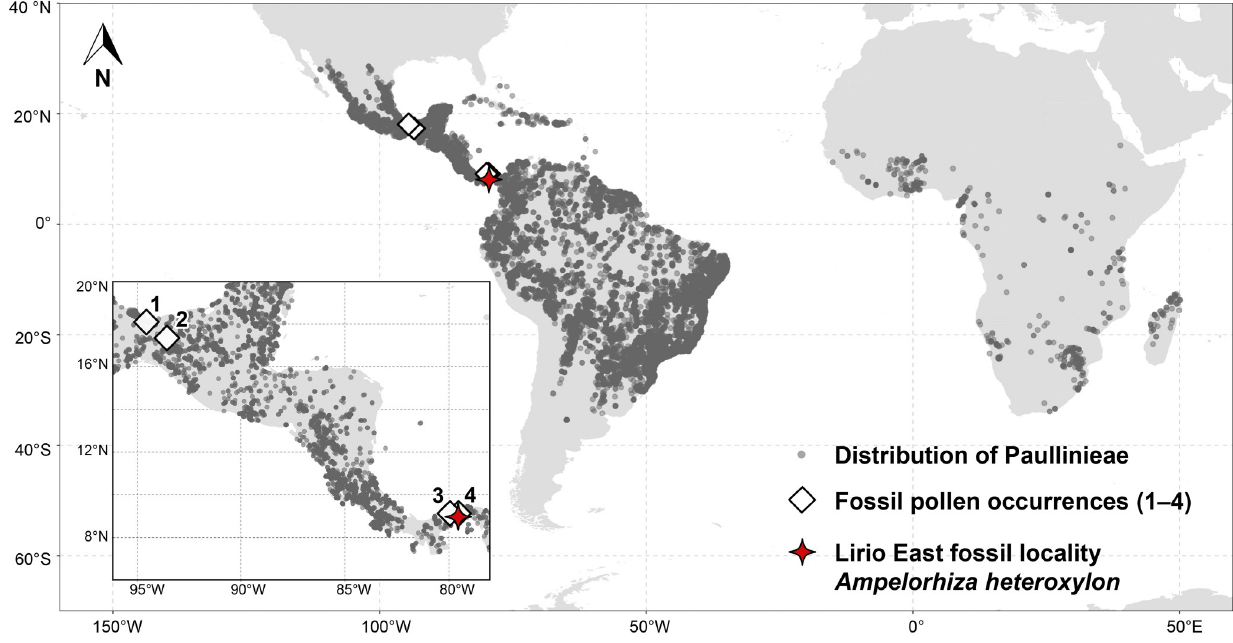
Fig 1. Native distribution of Paullinieae and fossil occurrences. Modern occurrence data from the BIEN database [45, 46]. Red star indicates the location of the Lirio East fossil site where the fossil roots were collected. Fossil pollen occurrence codes: 1 = Serjania sp., upper Miocene Paraje Solo Formation [47– 49]; 2 = Serjania sp. and Paullinia sp., lower-middle Miocene Me´ndez Formation [50]; 3 = Serjania sp. and Paullinia sp., upper Miocene Gatun Formation [49, 51]; 4 = Serjania sp., Paullinia sp., and Cardiospermum sp., upper Eocene Gatuncillo Formation [48, 52] Occurrence data were extracted from BIEN ver. 4.1 database using the RBIEN package [46], supplemented with C. pechuelii data from GBIF [53]. Cardiospermum spp. distribution data follows native ranges determined by [54, 55] (excluding controversial range in India).